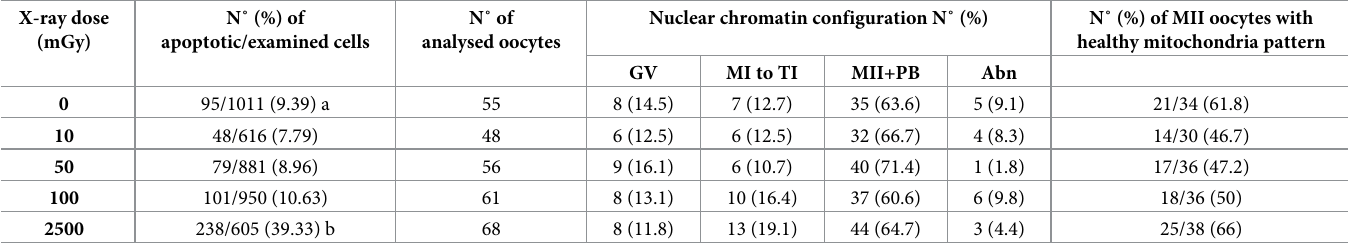
Chi-square test: a,b P < 0.001. For each experimental condition, three replicates were performed with 20–25